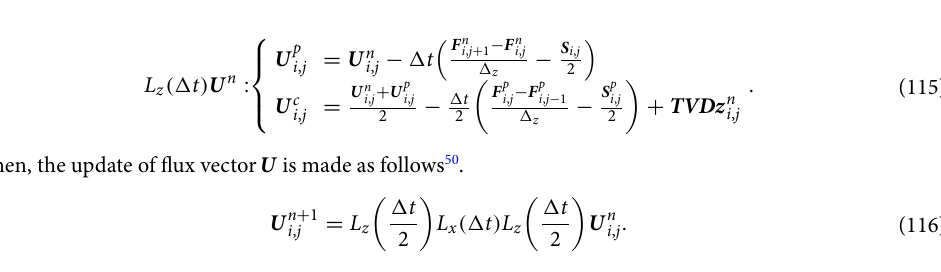
Figure 10. Semi-log plot of fine-grid solution φ 1 with error bars calculated by GCI 21 fine ( p ave ) for a 65 2 π and t = at y =